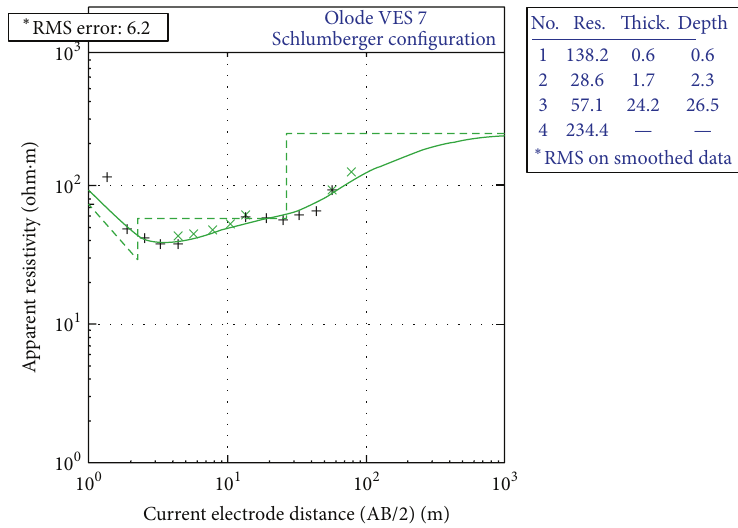
Figure 19: Sounding curve of VES 7.